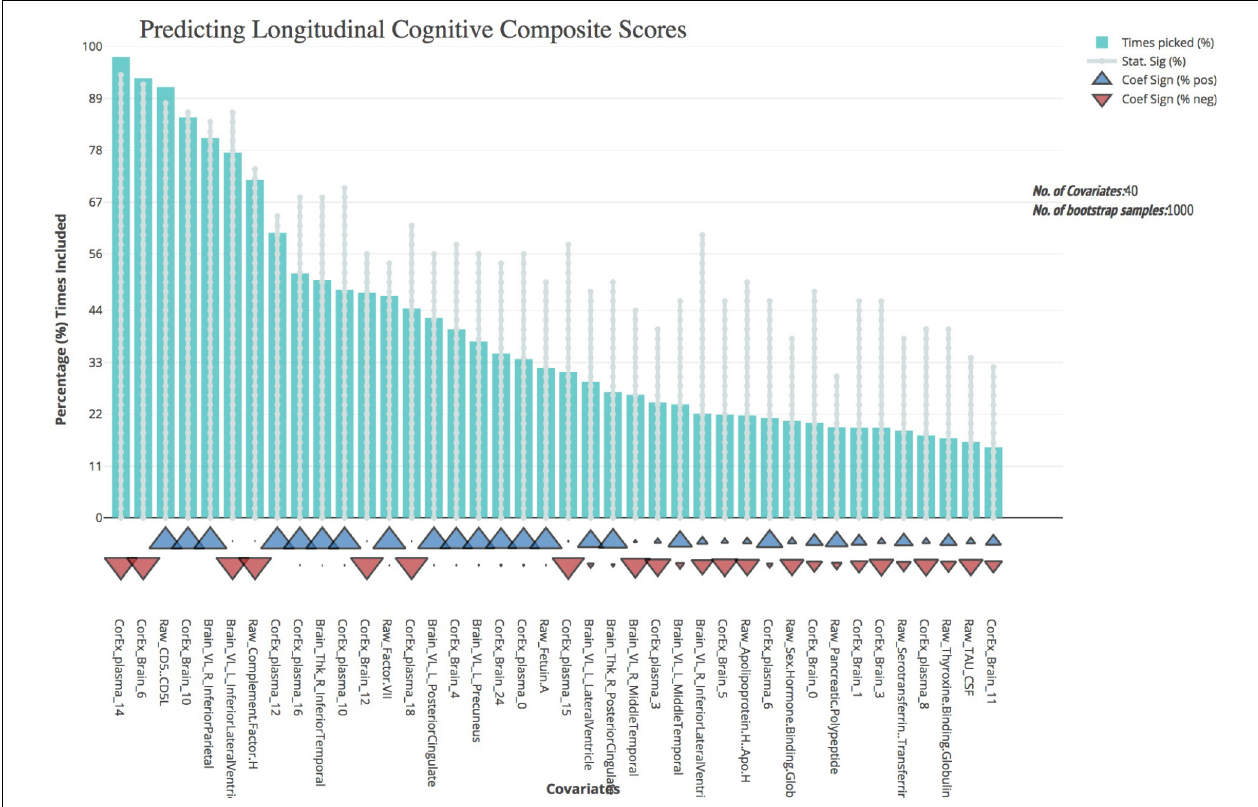
FIGURE 4 | Bootstrap regression results for a longitudinal cognitive composite score. As outlined in the Methods, we created a longitudinal cognitive composite score broadly encompassing executive function, orientation, attention, verbal, short-term, and working memory. Scores are based on change from baseline to 1-year follow-up and were significantly associated with progression to AD within the baseline CN and MCI groups ( p < 0.001) and of AD longitudinally across all groups ( p < 0.001). To understand the most predictive features of this score, we performed feature selection across feature types and then ran bootstrap stepwise regressions using 1,000 permutations. The top features are shown on the left; arrows underneath the histograms indicate the direction of effect for each measure. A prefix of “Raw” and “Brain” are used to denote the original measures, while “CorEx” indicates the transformed factors identified using CorEx. Corresponding regions included in the CorEx factors are outlined in Figures 2 , 3